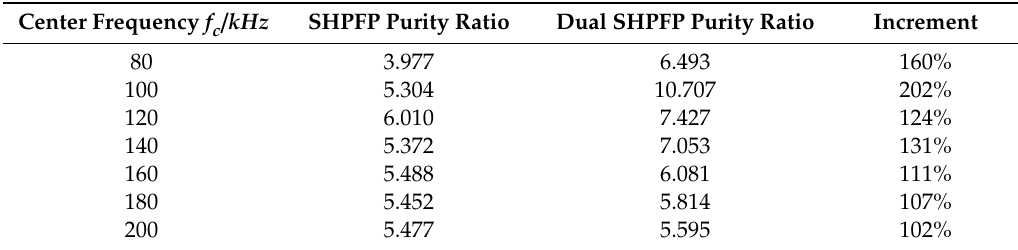
Table 2. Comparison of the purity ratio at di ff erent center frequencies.